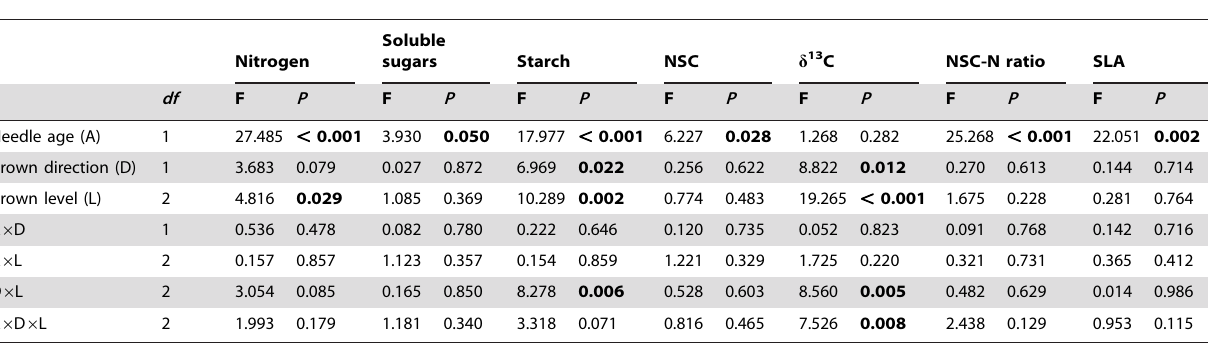
Table 1. Effects of needle age, crown direction, and crown level on soluble sugars, starch, non-structural carbohydrates (NSC), and total nitrogen concentrations expressed on a dry mass basis, NSC-N ratio, d 13 C, and SLA in Pinus koraiensis needles. F- and P -values are given ( n =